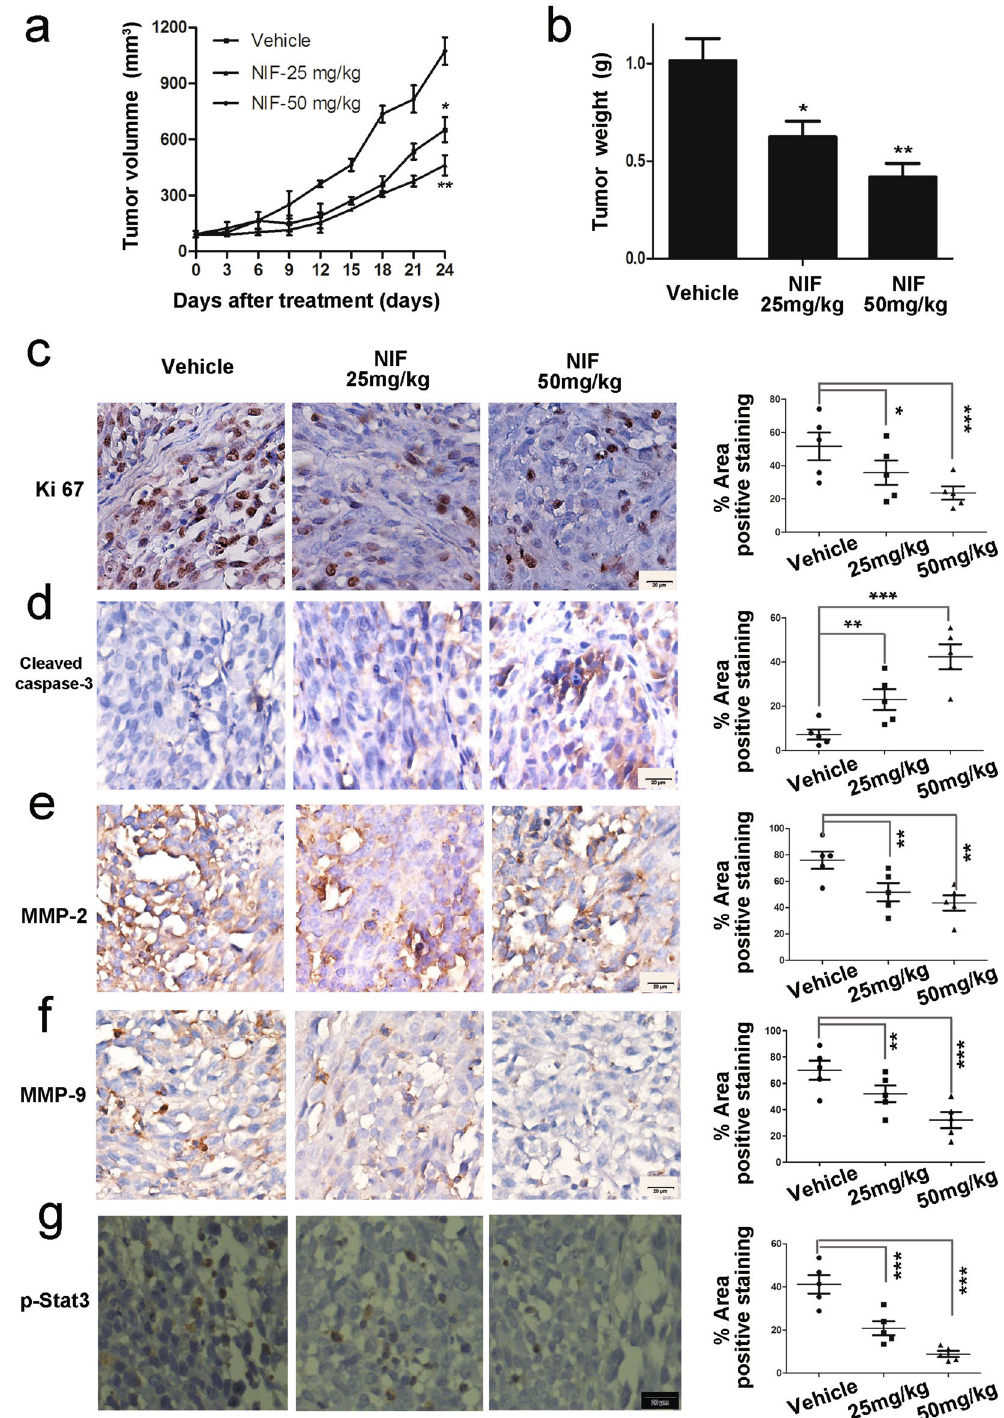
Figure 5. Effects of nifuroxazide on tumor growth in vivo. Mice implanted with A375 xenografts were treated with 25 and 50 mg/kg/day when the tumors grew to about 100 mm3. ( a ) Tumor volumes were measured every 3 days and presented as mean ± SD (n = 6, * P < 0.05; ** P < 0.01). ( b ) The bar charts of tumor weight. ( c ) Tumor cell proliferation was evaluated through immunohistochemical analysis staining with Ki67 and the statistical data of Ki67 positive cell number were shown on the right. ( d ) The apoptosis of tumor was determined by cleaved caspase-3 immunohistochemical staining and the statistical data of CC-3 positive cell number were shown on the right. Similarly, the immunohistochemical analysis was performed to measure the expressions of MMP-2 ( e ), MMP-9 ( f ) and p-Stat3 ( g ) in tumor tissues. P values for comparison of two groups were determined by 2-tailed Student’s t test (* P < 0.05; ** P < 0.01; *** P < 0.001 vs vehicle